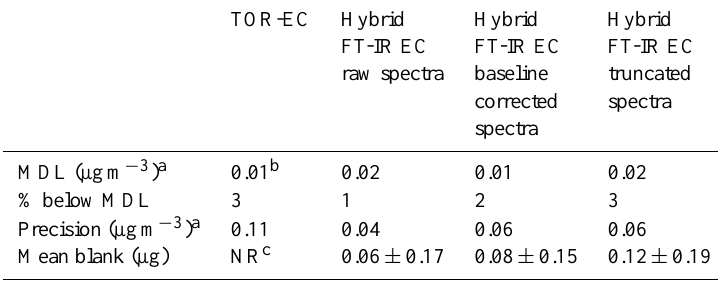
Table 1. MDL and precision for Hybrid FT-IR EC and TOR EC.